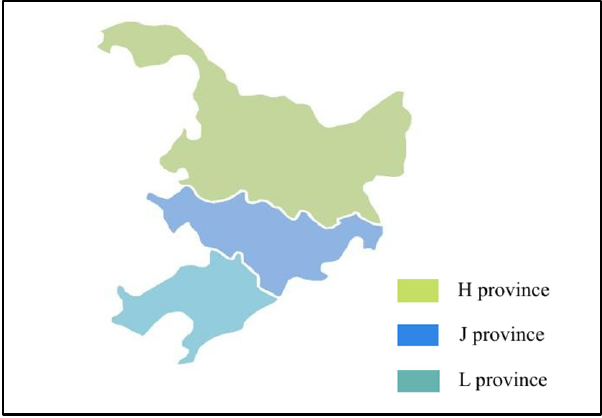
Figure 1. Administrative division of district M.